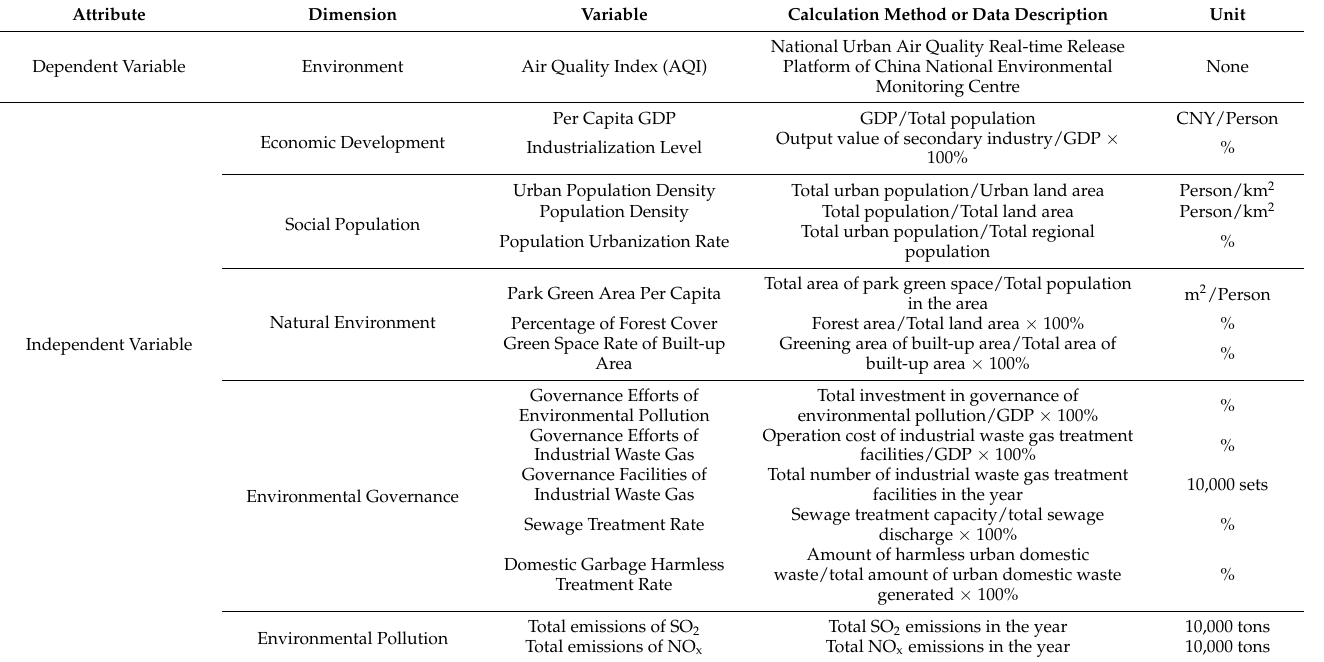
Table 1. Index system of influencing factors of Air Quality Index